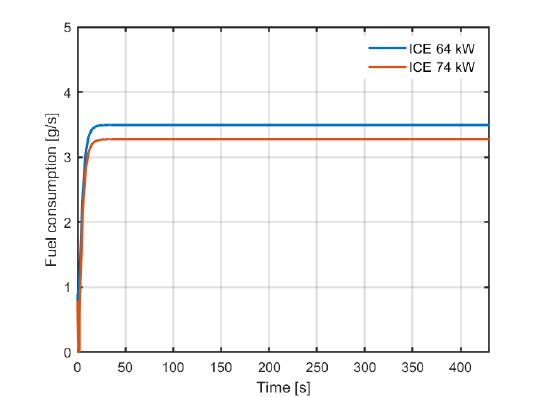
Figure 18: The fuel consumption of the underground loader